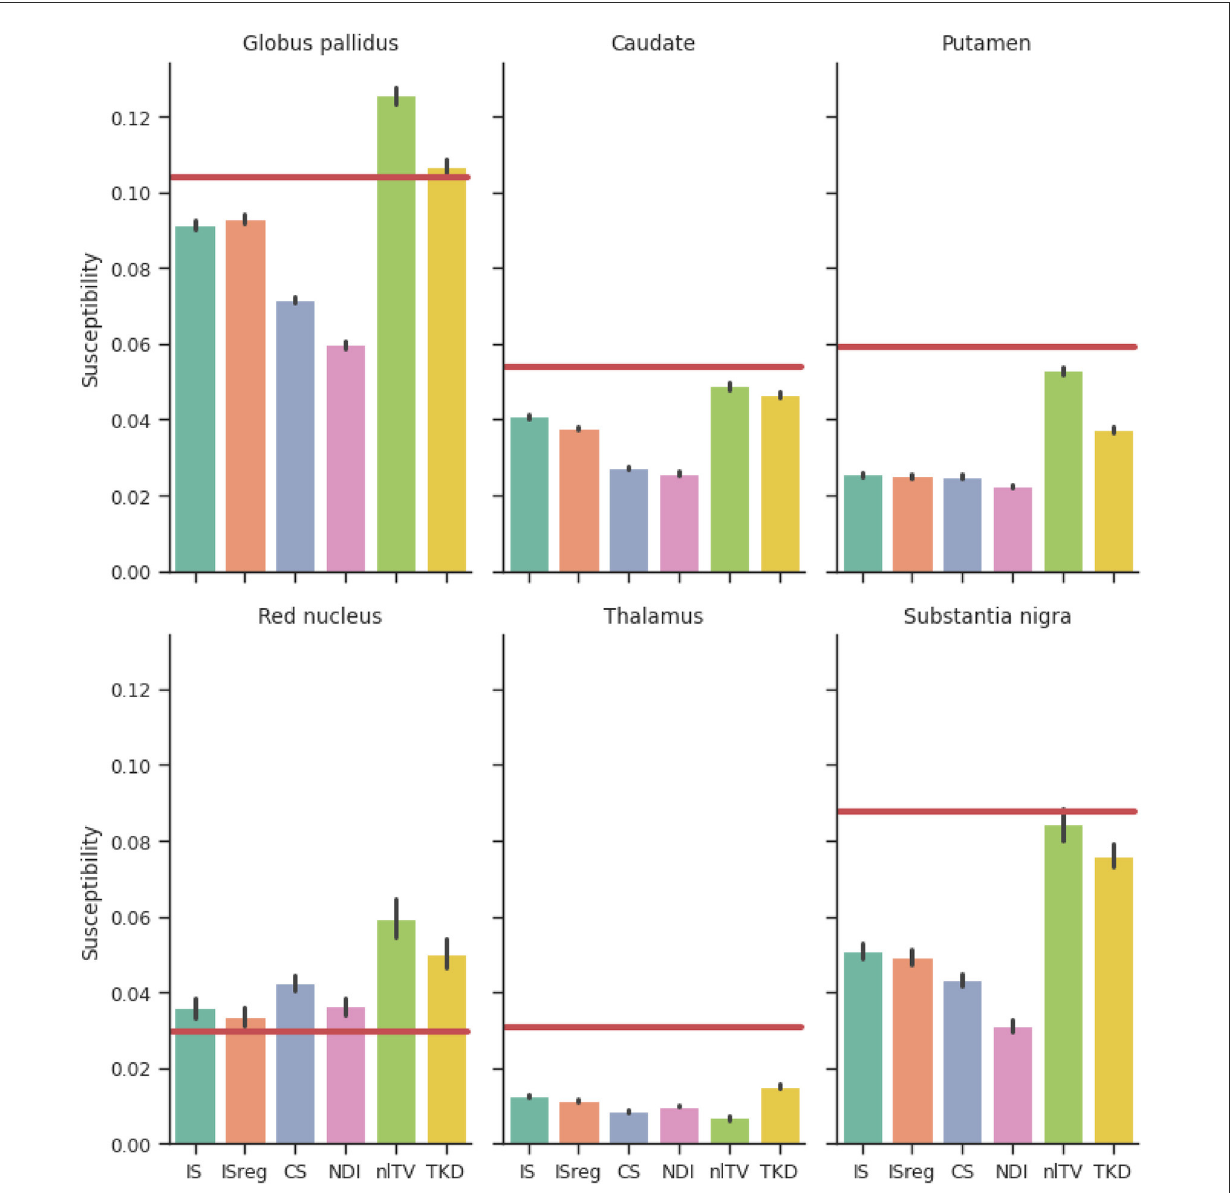
FIGURE10 Reconstructed susceptibility values for deep gray matter regions of interest in the 5 volunteer datasets. Red lines are averaged literature values from Bilgic et al. (2012) and Santin et al. (2017), and vertical black lines signify 3 standard errors. IS, Incomplete spectrum ( t well = 0.25); ISreg, Regularized IS = 1 · 10 − 5 ); NDI, Nonlinear Dipole Inversion (w. automatic stopping); (Same parameters as IS & CS); CS, Compressed sensing ( 9 : Daubechies 2, λ ℓ 1 FANSI, Fast Nonlinear Susceptibility Inversion ( λ TV = 1 · 10 − 5 ); TKD, Thresholded k-space division ( λ = 2 / 3, w. PSF